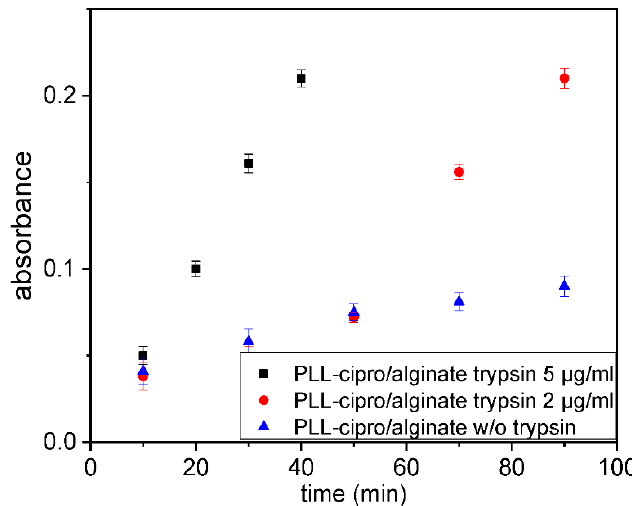
Figure 4. Absorbance at 278 nm, which corresponds to the ciprofloxacin concentration in the dialysate as function incubation time in PBS buffer (pH 7.4) without, with 2 µg/mL or 5 µg/mL trypsin, respectively, at 37 °C.